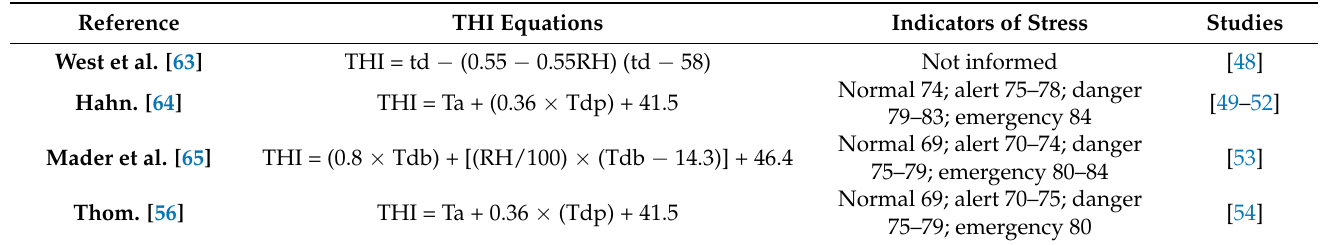
Table 3. Temperature humidity index (THI) equations that were used in the studies included in this review to determine the thermal environment for lactating cows raised in a compost barn system.